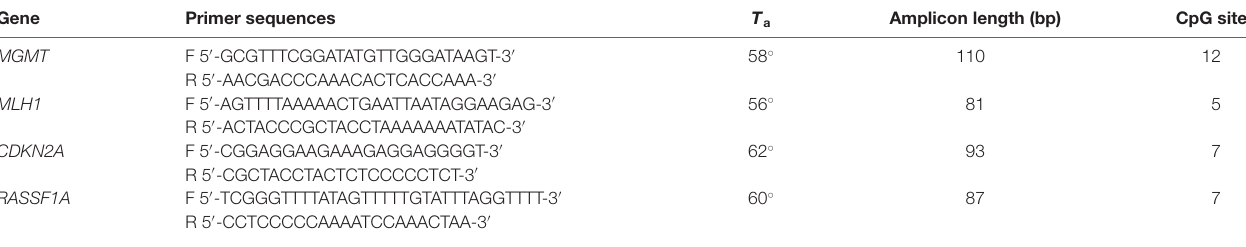
TABLE 2 | Primer sequences and annealing temperatures ( T a ) used during MS-HRM analysis, amplicon length, and number of CpG sites for each gene. Gene Primer